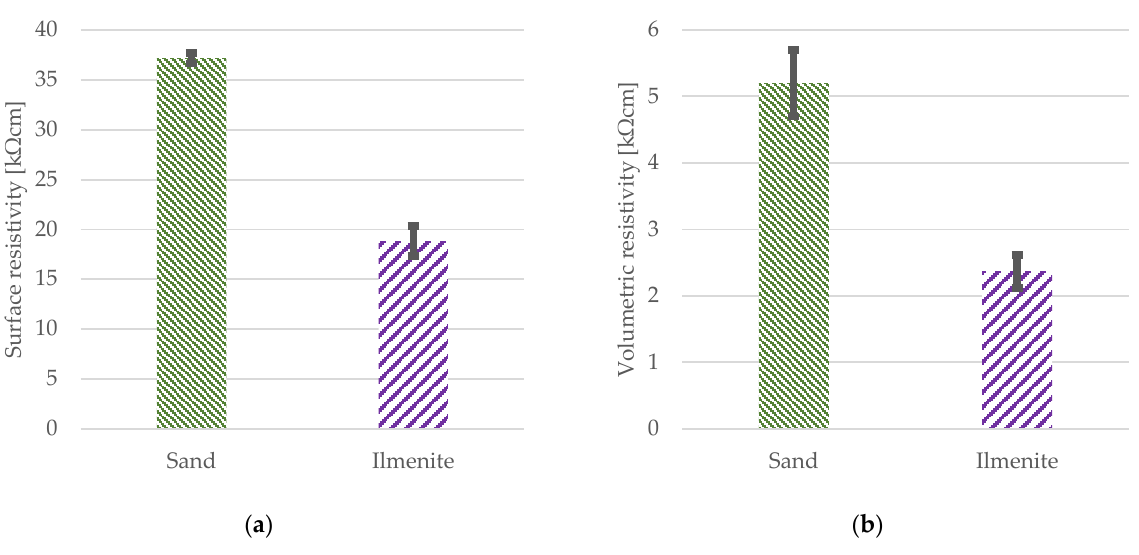
Figure 5. Resistivity: ( a ) surface and ( b ) volumetric. Table 2. The ratio between surface and volumetric resistivity.